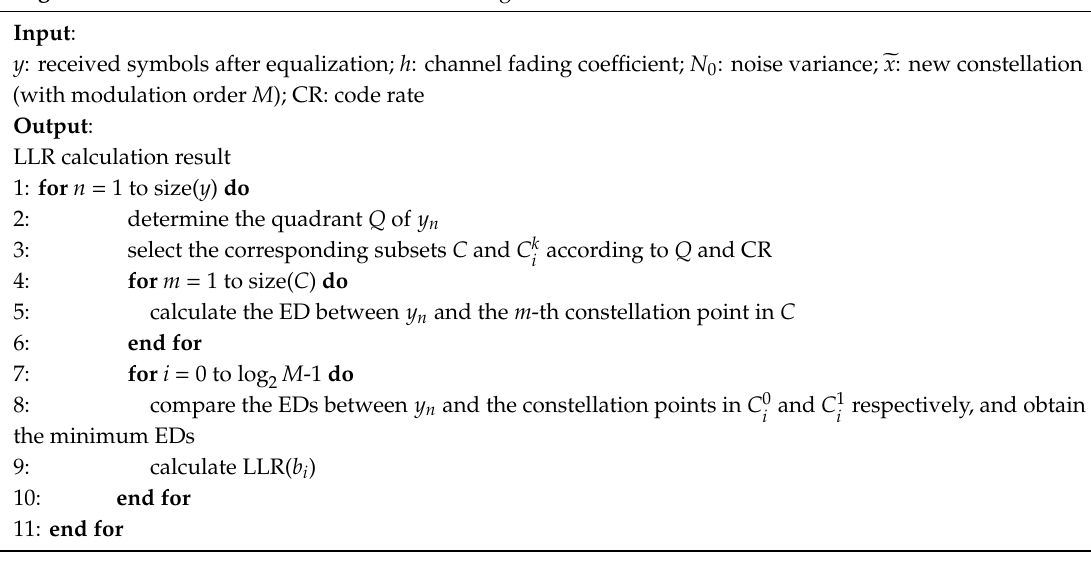
Algorithm 2 LLR Calculation Process of SCSR